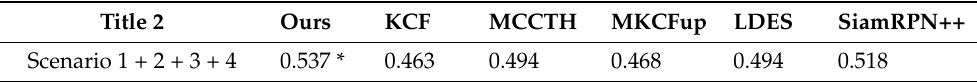
( b ) Figure 15. Tracking accuracy using Metrics-1 and Metrics-2: ( a ) tracking accuracy using Metrics-1; ( b ) tracking accuracy using Metrics-2.